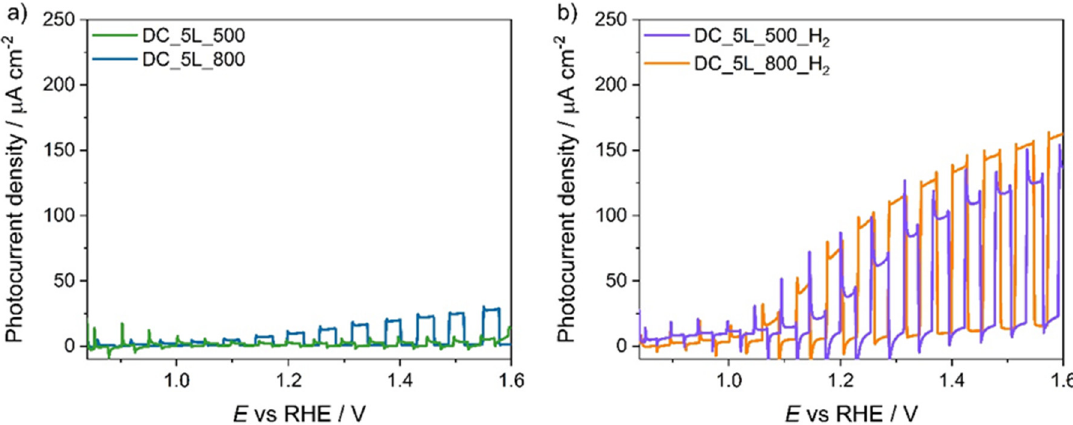
Figure 8 . Linear Sweep Voltammetry (LSV) plots of DC_5L_500 and DC_5L_800 films ( a ) before and ( b ) after hydrogenation.